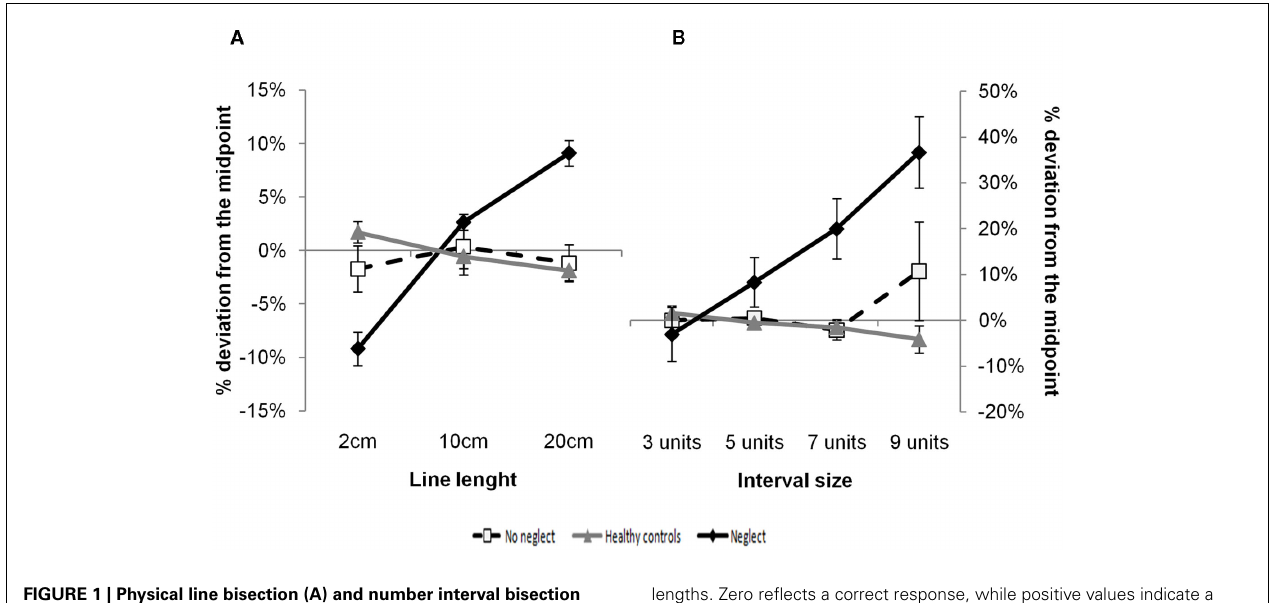
FIGURE 1 | Physical line bisection (A) and number interval bisection (B) in neglect patients, patients without neglect and healthy controls. Both figures show the average proportional difference between reported and correct midpoints for the different line and interval